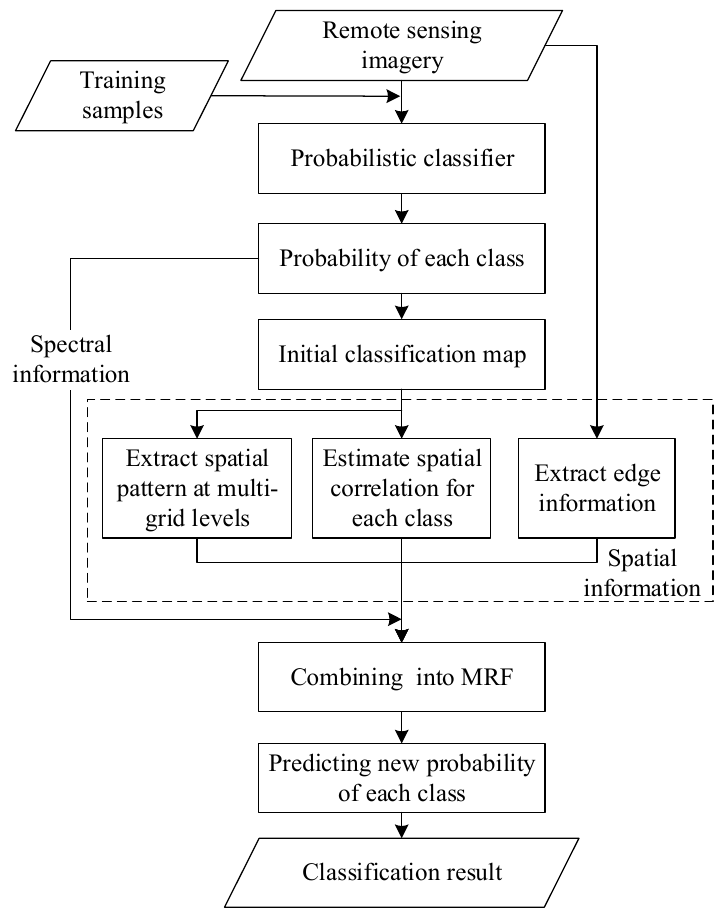
Figure 2. The flowchart of the contextual classification using an MIX-E model.